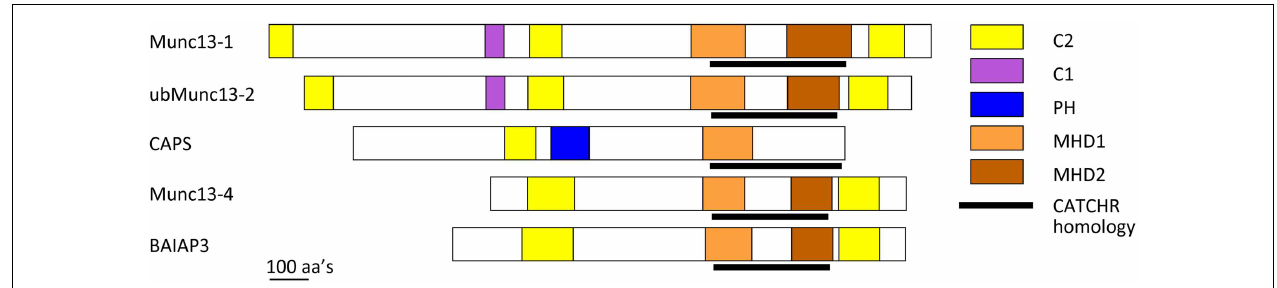
FIGURE 2 | Schematic of CAPS/Munc13 family of priming factors . Colored boxes indicate relative location of C2, C1, PH, MHD1, and MHD2 domains.The CATCHR homology region is indicated by black